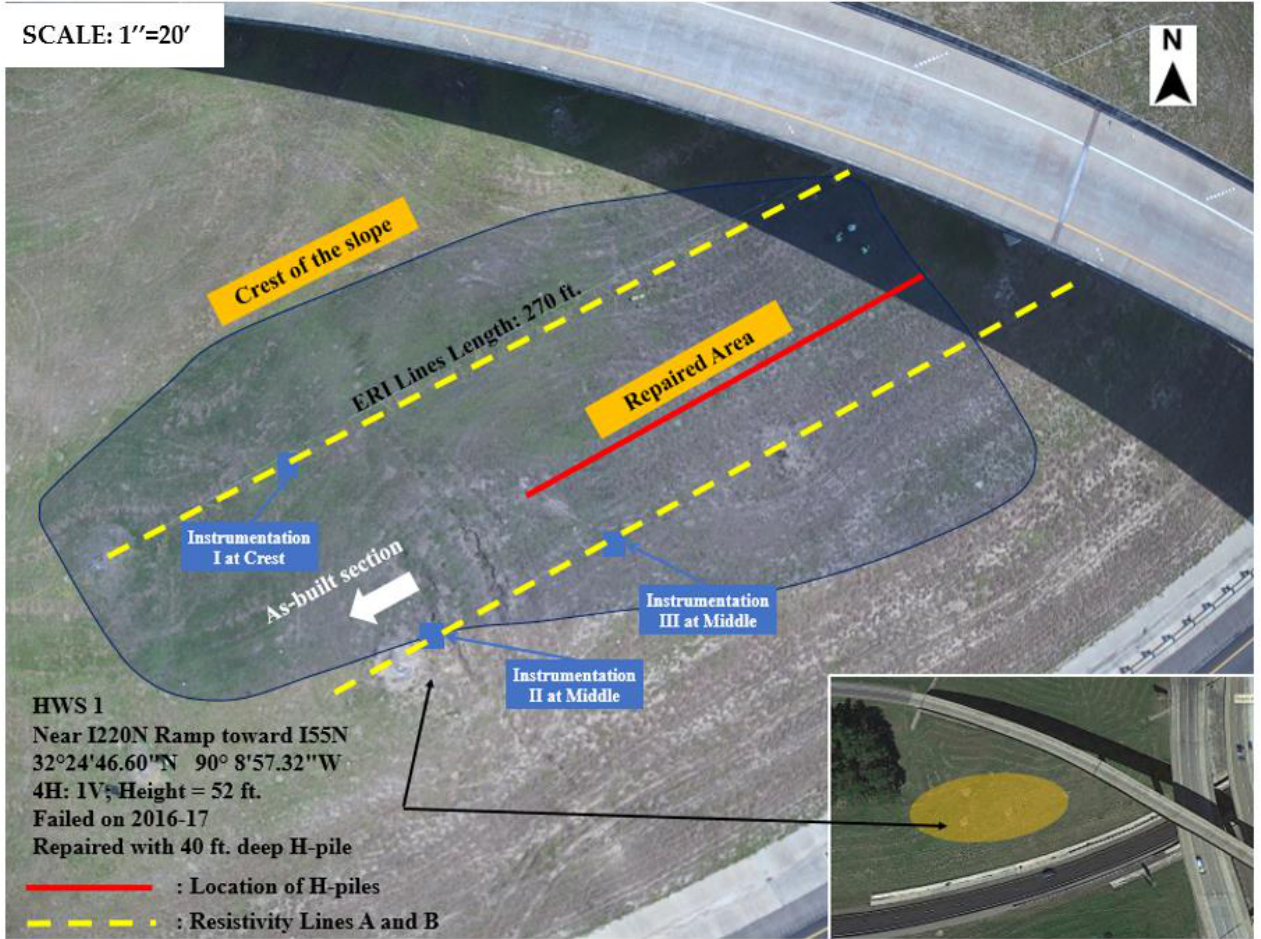
Figure 8. HWS 1 ERI and instrumentation layouts along with its characteristics (drone image-top view) ( 1′ = 1 ft = 0.305 m).